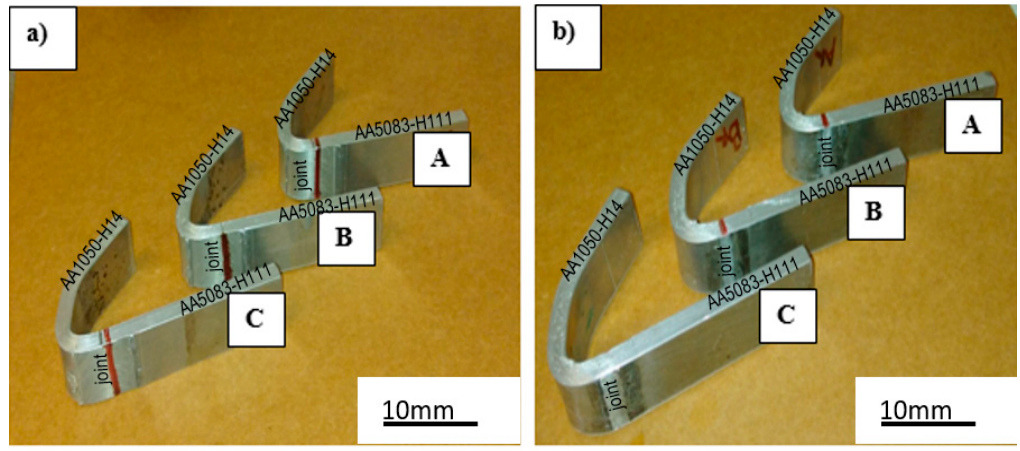
Figure 12. ( a ) Tested bending specimen (face), ( b ) Tested bending specimen (root).